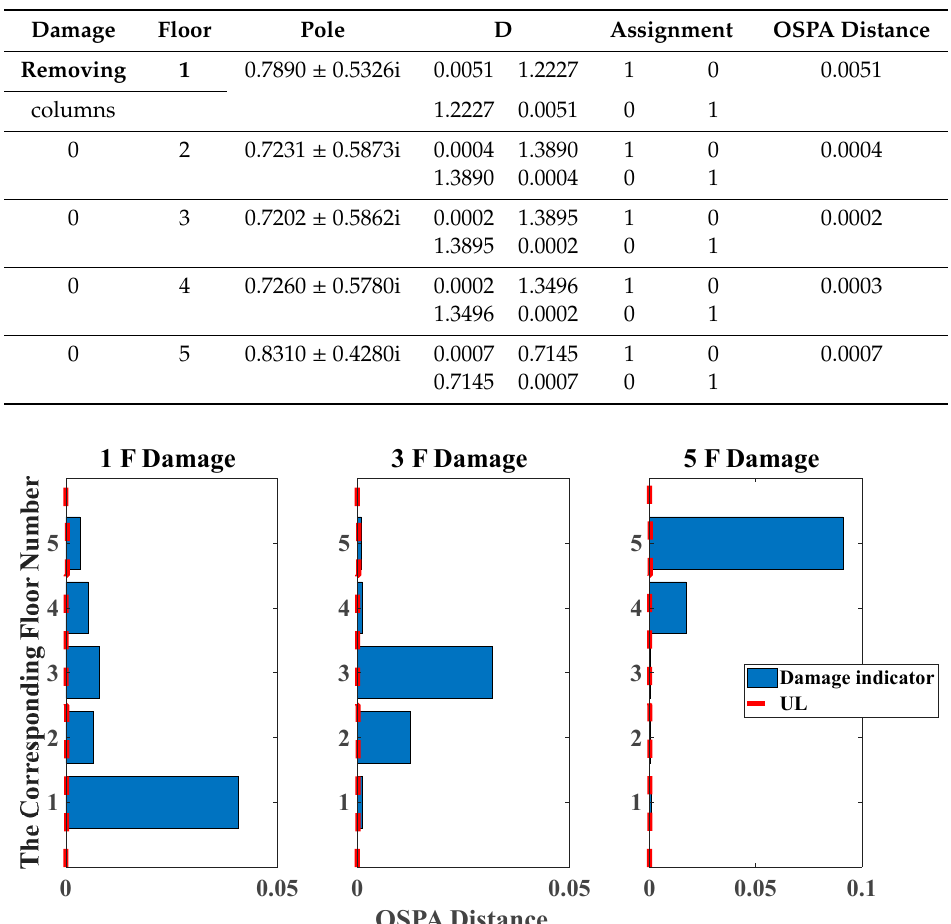
Figure 27. Damage detection results based on the OSPA distance (removing braces, white noises excitation, autoregressive model, data length = 4000, AR order = 2, OSPA.p = 2).